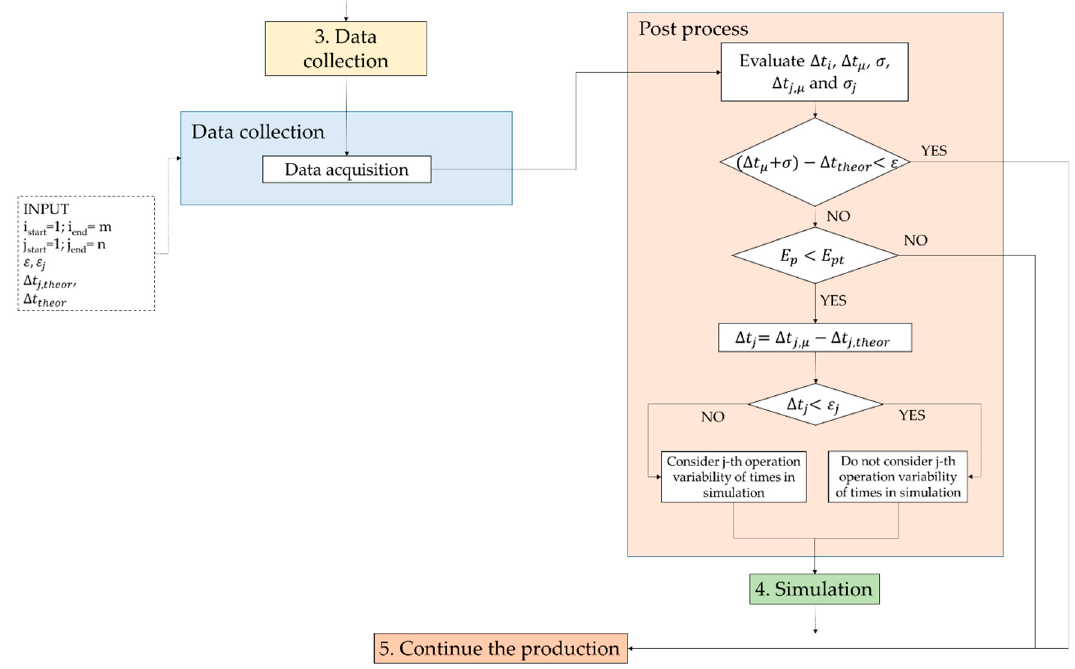
Figure 5. Modified procedure for data collection and post process.